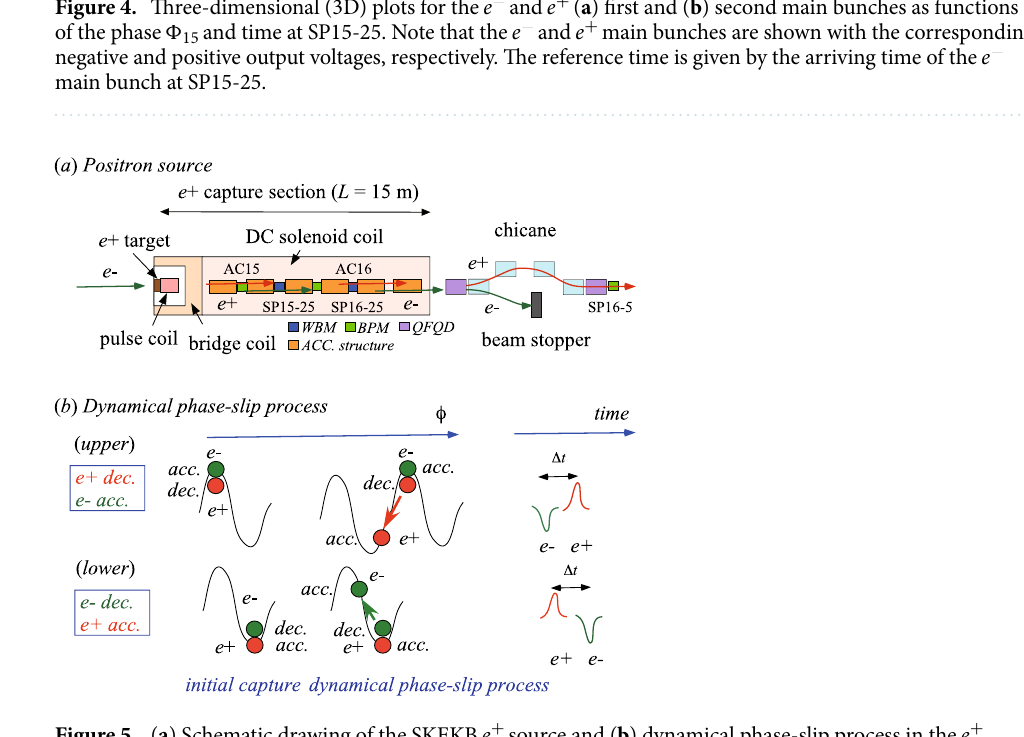
Figure 5. ( a ) Schematic drawing of the SKEKB e + source and ( b ) dynamical phase-slip process in the e + capture